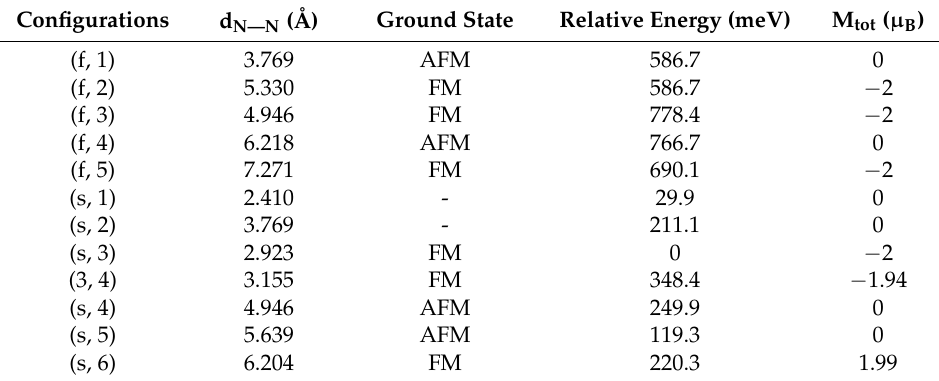
Table 2. The calculated results of each configuration for two N atoms doped in a 2 × 2 × 2 tetragonal BFO supercell with C-AFM magnetic